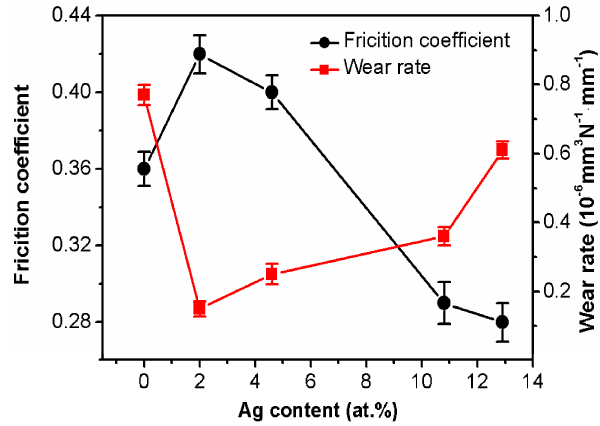
Figure 8. Friction coefficients and wear rates of NbCN-Ag composite films with different Ag contents.